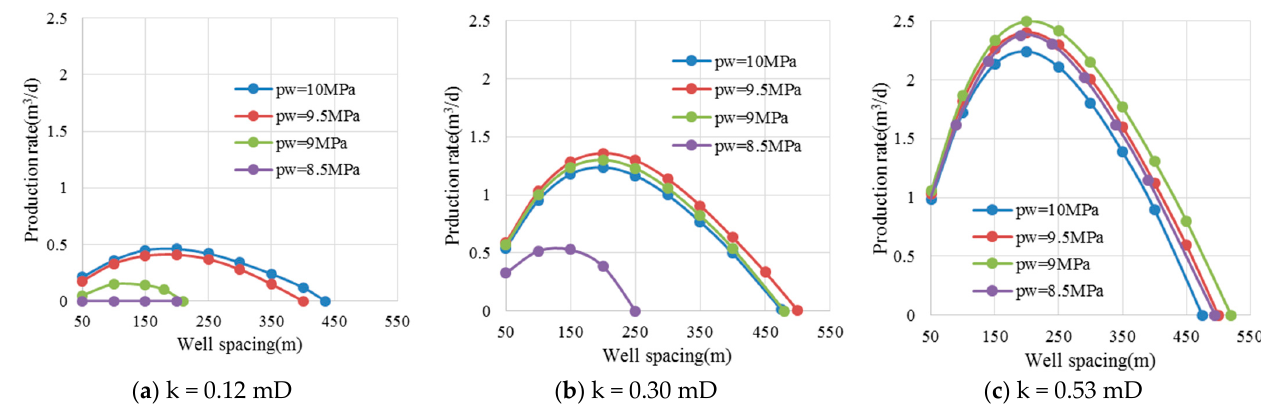
Figure 19. The relationship between the production rate and the well spacing after fracturing.